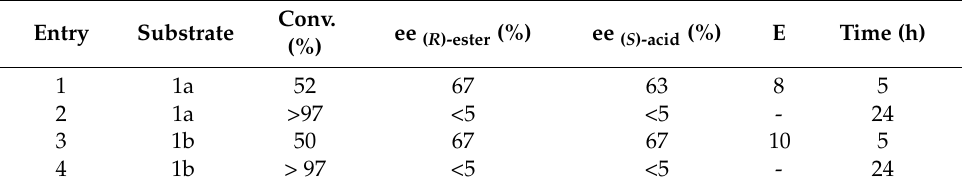
Table 1. Hydrolysis of 1a-b with pig liver esterase (PLE); Conditions: [S] = 2.5 mM, [PLE] = 7.5 mg/mL in 100 mM phosphate buffer at pH = 7.0 and DMSO (5%), 30 °C.